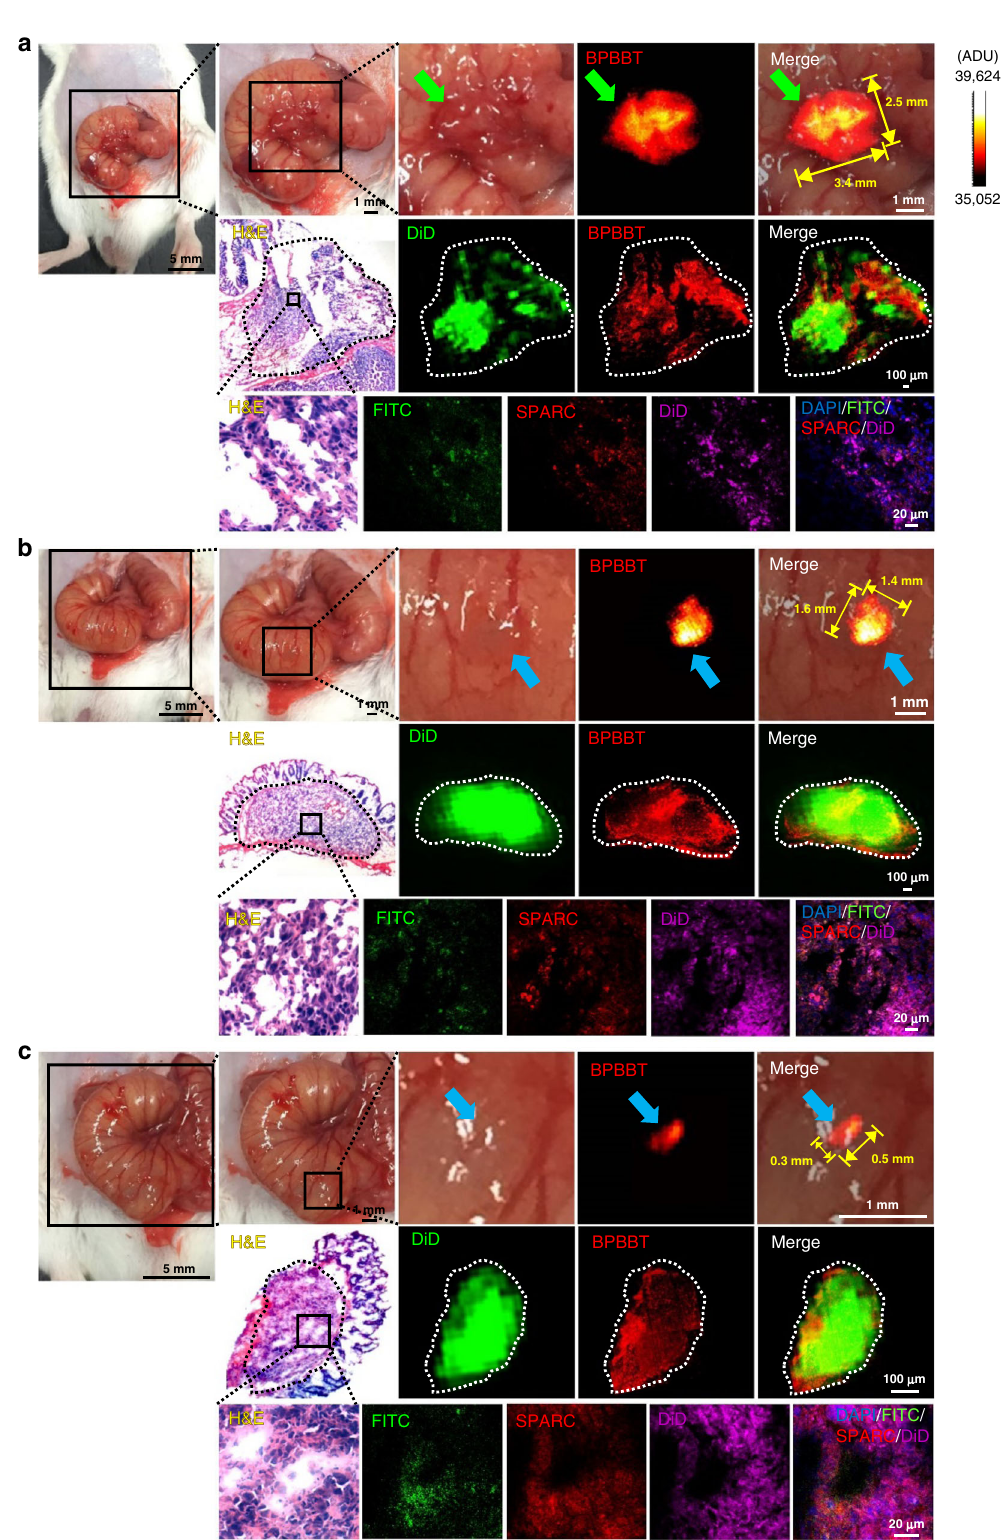
Fig. 6 Intraoperative NIR-II imaging of orthotopic mouse colon tumor by BPBBT NPs. BALB/c mouse 1 bearing DiD-labeled CT26-Luc tumor was i.v. injected with BPBBT NPs (20 mg kg − 1 ). After 30 h, an incision was made in the abdominal skin of mouse under the anesthetic condition to expose cecum and the adjacent area for NIR-II imaging. a NIR-II live imaging (upper) and histologic analysis (middle and lower) of primary tumor in the cecum of the tumor-bearing mouse. Green arrows, primary tumor lesion. b, c NIR-II live imaging (upper) and histologic analysis (middle and lower) of metastatic tumor foci in 1.6 mm × 1.4 mm size ( b ) or in 0.5 mm × 0.3 mm size ( c ) in the cecum. Blue arrows, metastatic lesions. Dashed circles, tumor area. See Supplementary Figs 11 and 12 for the imaging of mice 2 and 3, Supplementary Movie 1 for the imaging of mouse